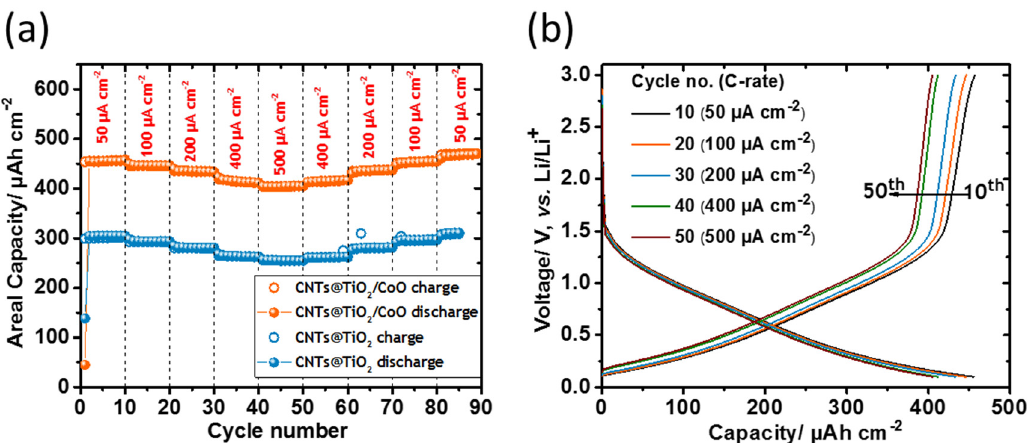
Figure 6. Rate capability of CNTs@TiO 2 and CNTs@TiO 2 /CoO NT anodes ( a ); typical voltage profiles vs. Li/Li + for the 10th, 20th, 30th, 40th, and 50th cycles against the areal capacity of TiO 2 /CoO NT anodes ( b ) (measured at a current rate of 50, 100, 200, 400 and 500 µA·cm − 2 , respectively). Table 1. Performance of TiO 2 -CNTs and CoO/CNTs anode materials.